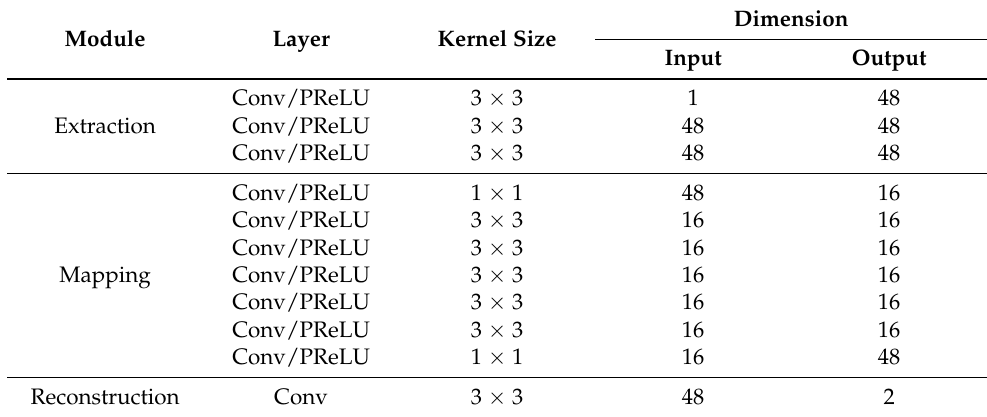
Table 1. The configuration of the sub-networks.